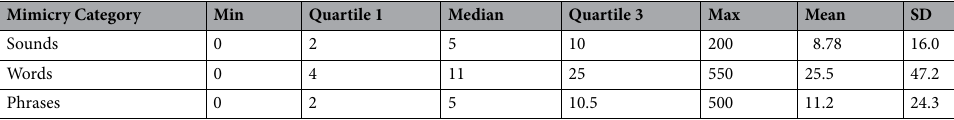
Table 1. Repertoire size summary statistics for all (n = 877) companion parrots reported to mimic human